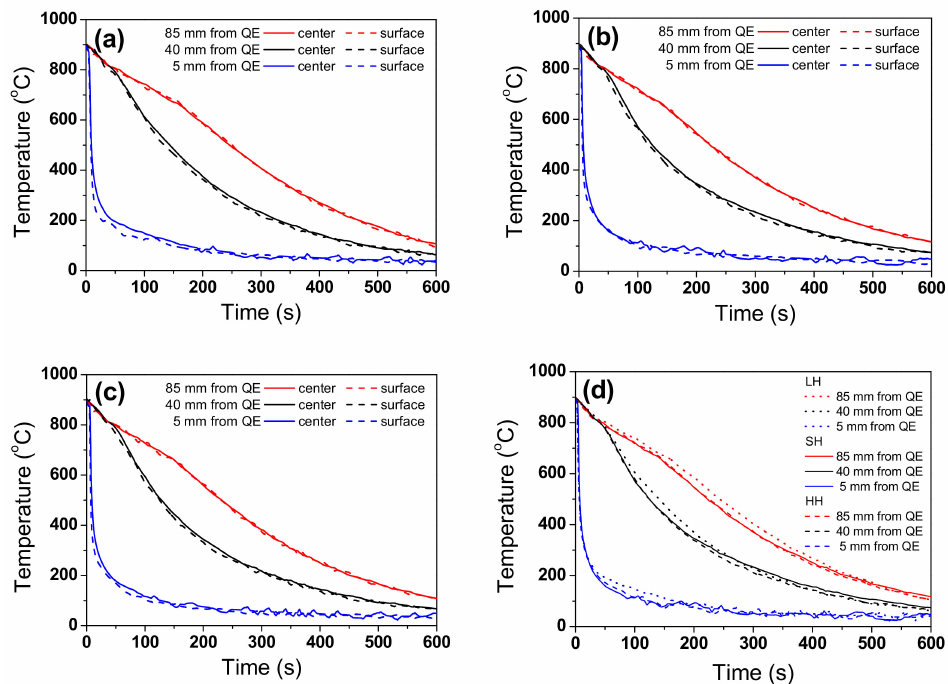
Figure 6. Temperature profiles of the Jominy specimen with the cooling conditions of the ( a ) low height (LH), ( b ) standard height (SH), ( c ) high height (HH), and ( d ) comparison of temperature profiles at the center areas of the Jominy specimen with the height of water jet.